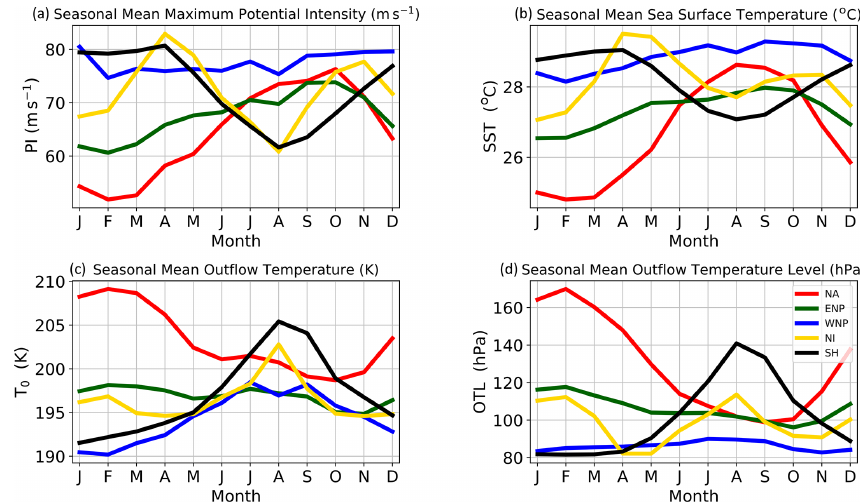
Figure 7. 2004 seasonal cycles of potential intensity in meters per second (a) , sea-surface temperature in K (b) , outflow temperature in K (c) , and outflow temperature level in hPa (d) calculated with pyPI and averaged over the main development regions: the North Atlantic (red), eastern North Pacific (green), western North Pacific (blue), North Indian (yellow), and Southern Hemisphere